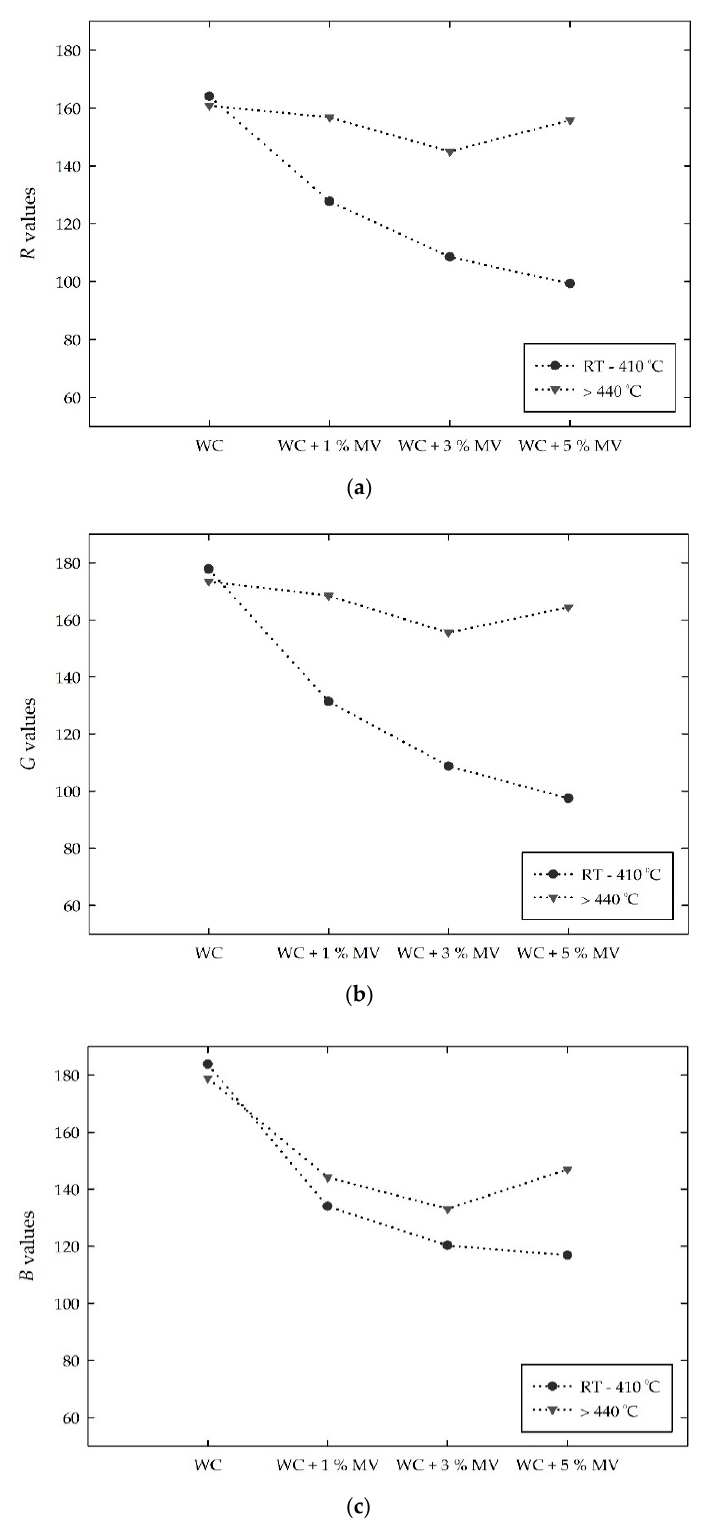
Figure 10. Comparisons of the RGB values for the white cement (WC) mixed samples with increasing temperatures: ( a ) R values; ( b ) G values; and ( c ) B values.